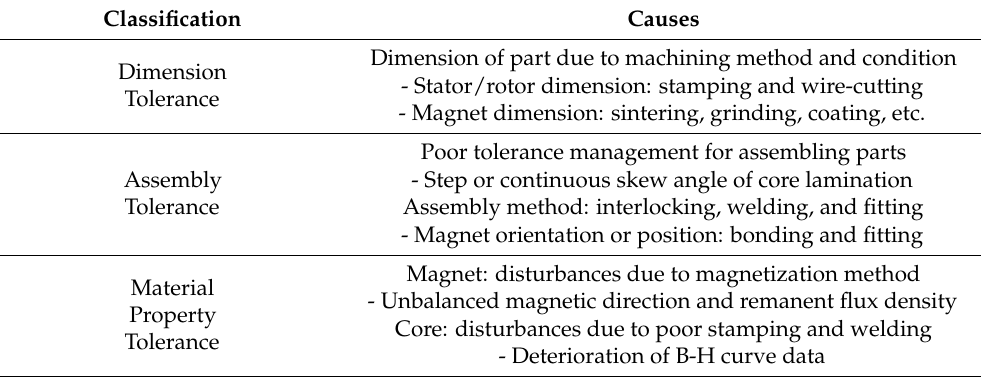
Table 5. Classification and causes for manufacturing disturbances of motor. Classification Causes Dimension of part due to machining method and Dimension Tolerance